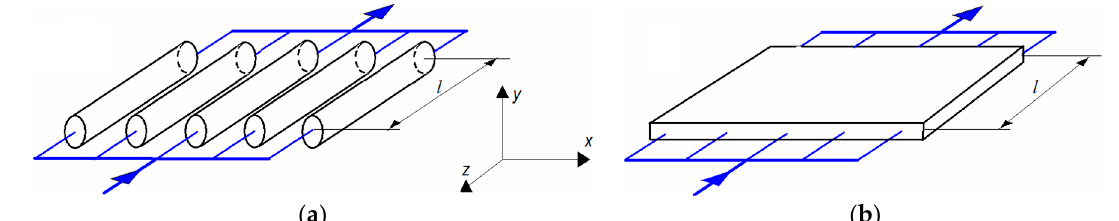
Figure 1. Considered systems: ( a ) Parallel pipes configuration; ( b ) Flat plate.